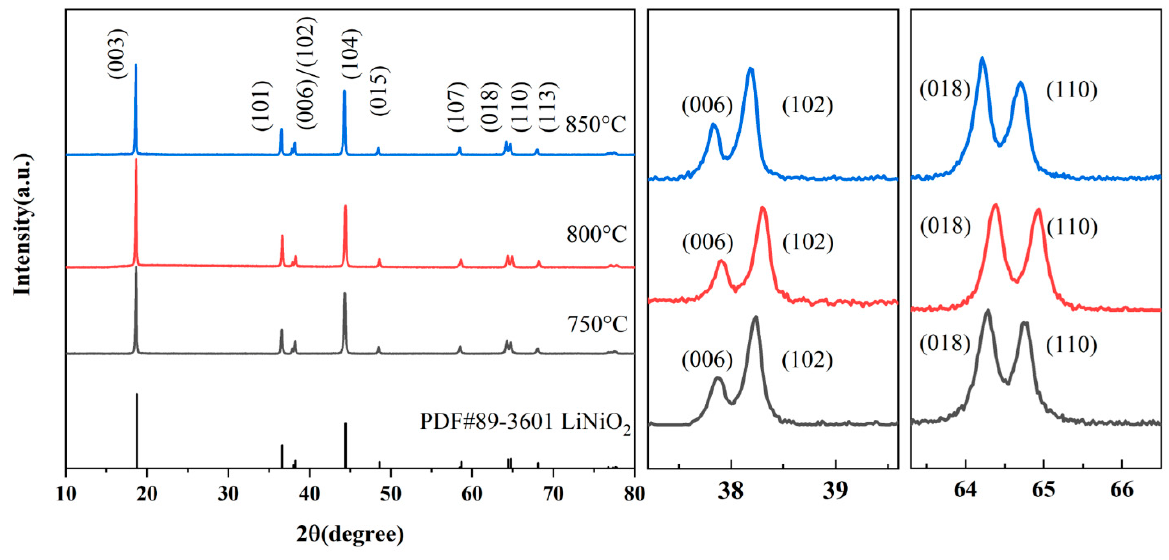
Table 1. Lattice parameters of NCM622 samples with different sintering temperatures.